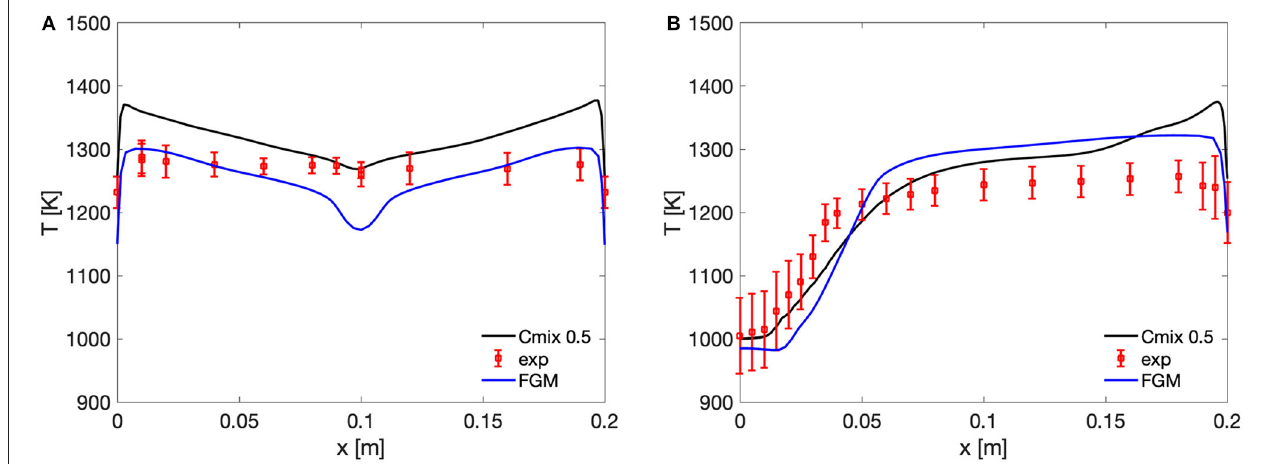
FIGURE 8 | Case 2 FGM and static PaSR with C mix = 0.5 results compared to experimental values along the central and lateral thermocouples. (A) Central thermocouple profiles. (B) Lateral